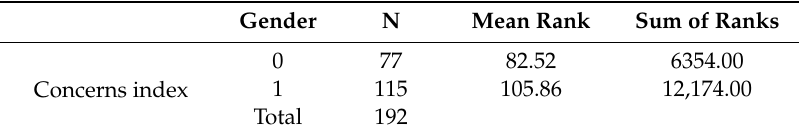
Table 9. Ranks concerns index and gender.